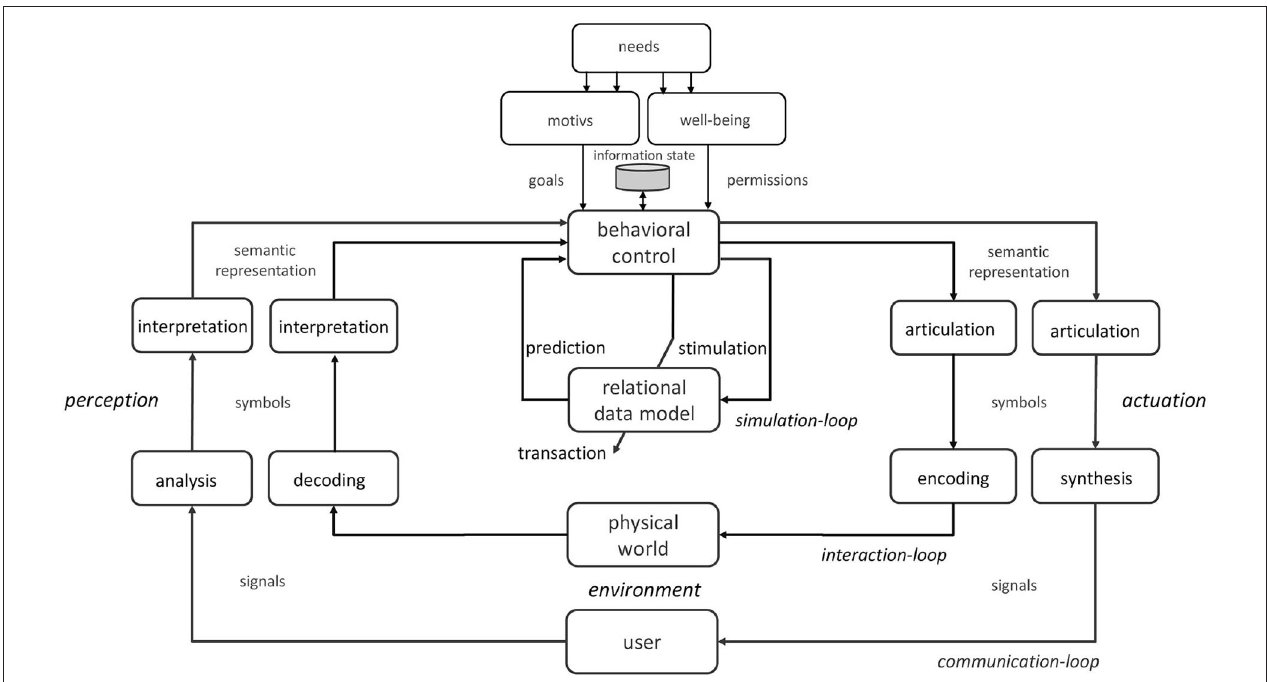
FIGURE 1 | Double cognitive loop using an embedded relational data model. The inner cognitive loop corresponds to the interaction between the agent and the environment (nonverbal information exchange). The outer cognitive loop is used for the communication between a speech-enabled agent and any other cognitive agent or natural language user (verbal information exchange). The flow of information between the behavioral control and the relational data model is embedded in a simulation loop and enables the simulation of actions as well as the prediction of effects. Since the simulation loop is not linked to the environment through perception and action, this loop is not referred to as a PAC. The exchange of information between two systems with different cognitive abilities (e.g., between humans and cognitive agents) is denoted as Inter-Cognitive Communication ( Baranyi et al.,